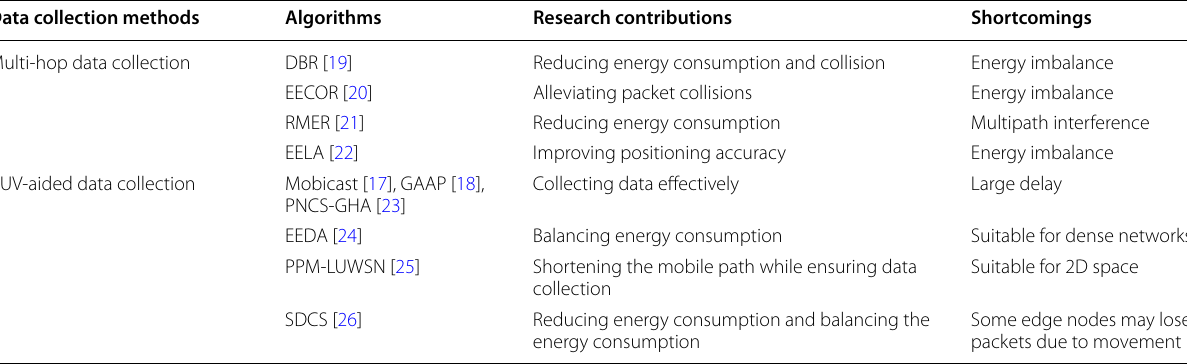
Table 1 Comparison of data collection methods Data collection